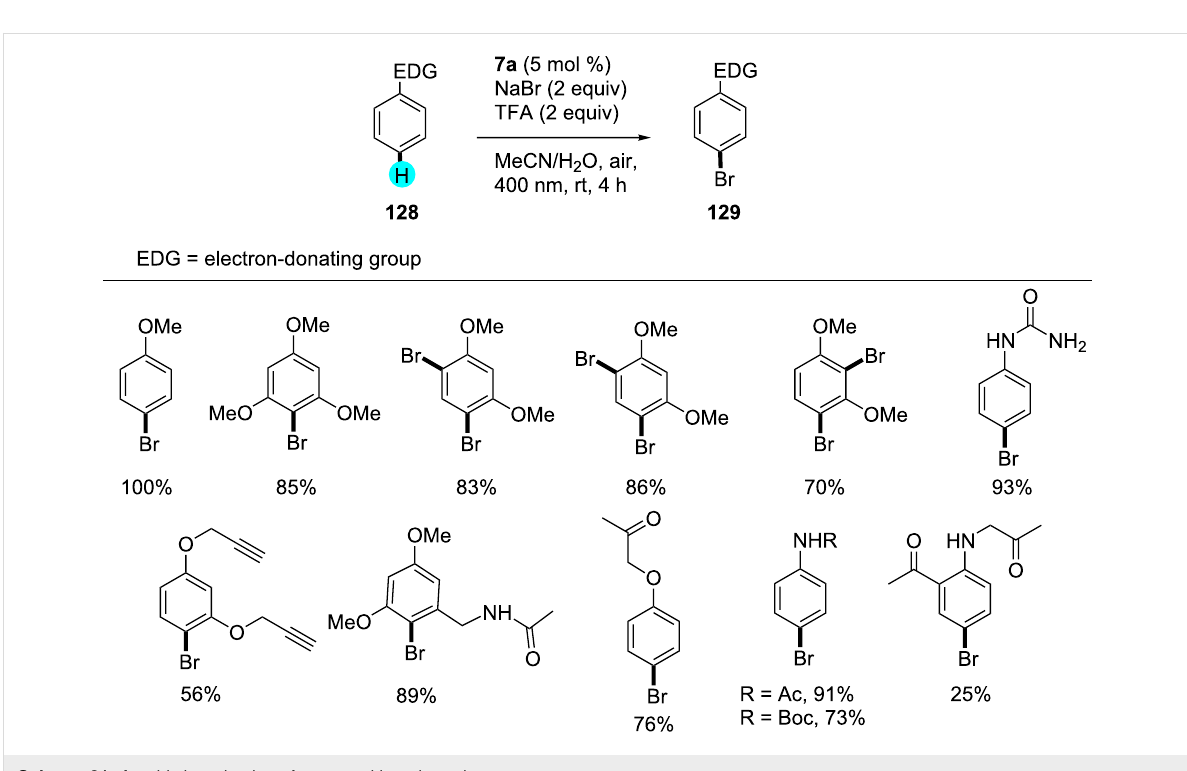
Scheme 21: Aerobic bromination of arenes with